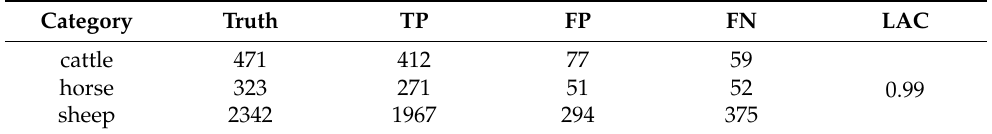
Table 10. Livestock accounting in testing